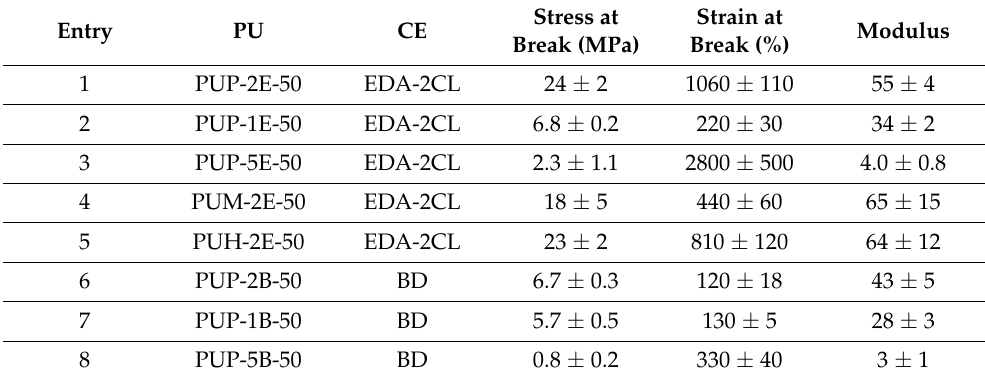
Table 3. Mechanical properties of the synthesized